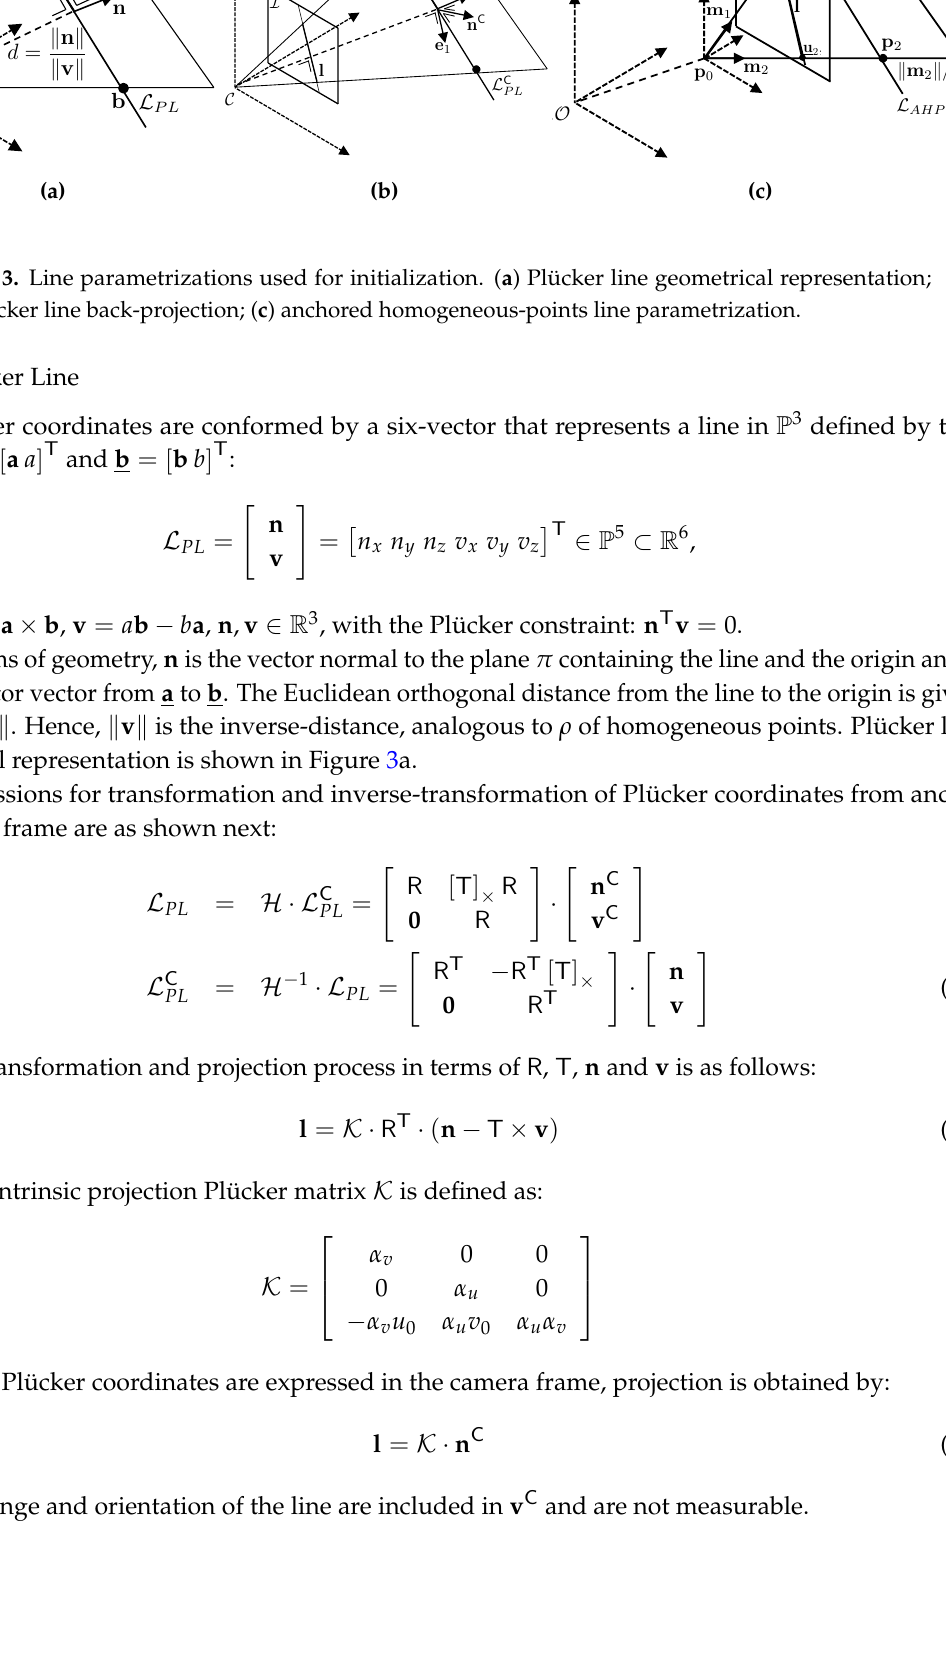
Figure 2: Pl¨ucker line geometrical representation. Image extracted from [ ? ] Pl¨ucker coordinates transformation from camera frame is performed as shown next: